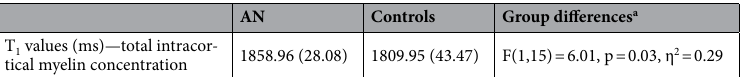
AN Controls Group differences a T 1 values (ms)—total intracor- tical myelin concentration